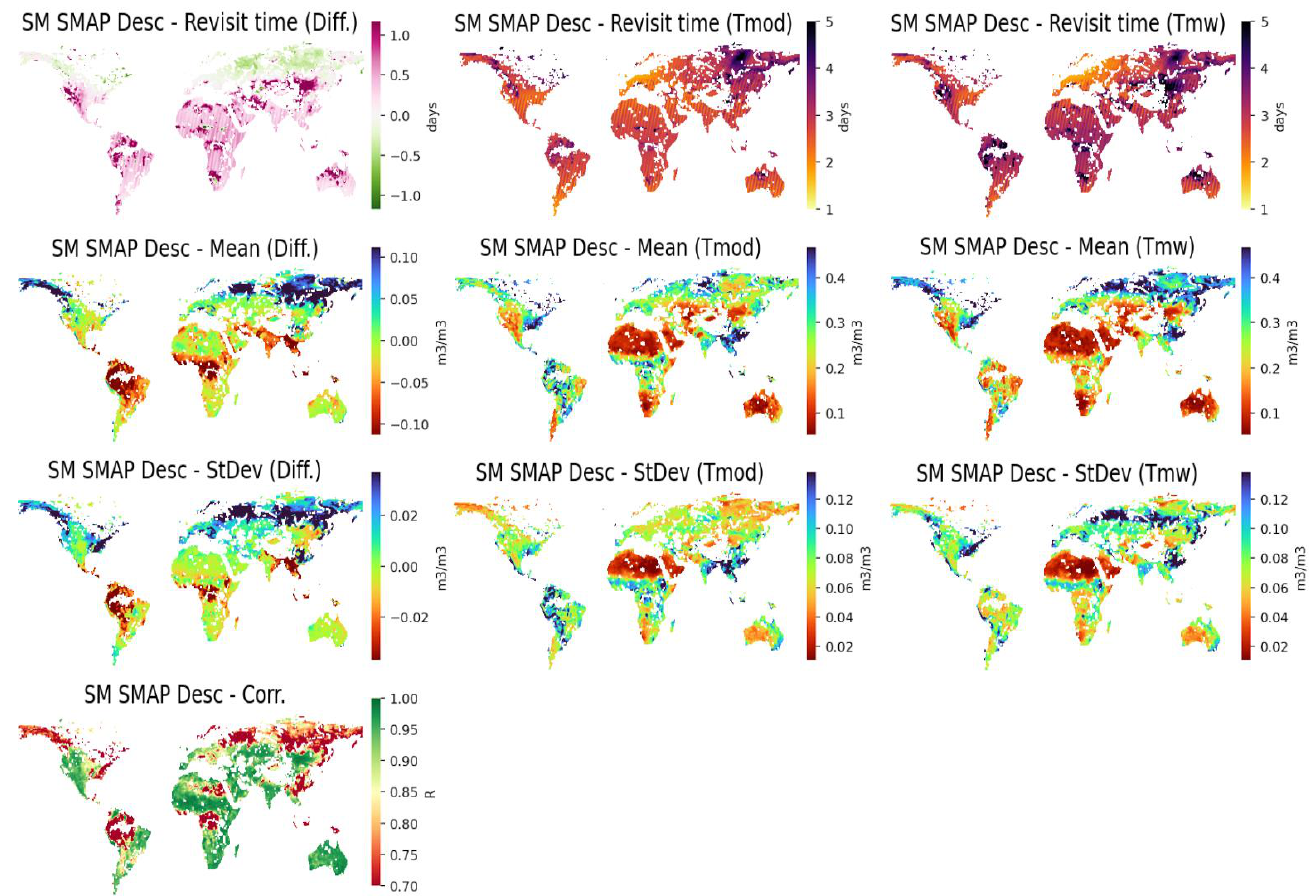
Figure 2. SMAP Desc SM mw retrievals compared to SM mod .